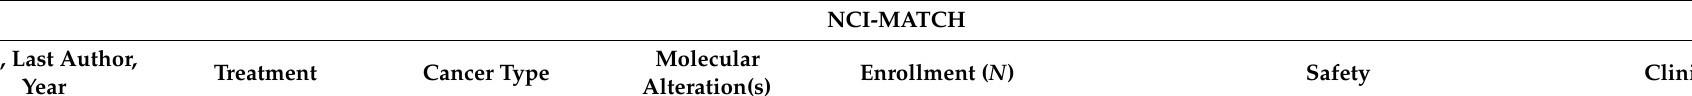
Table 3. Selected subprotocols of the non-randomized NCI-MATCH and TAPUR studies across tumor types with negative